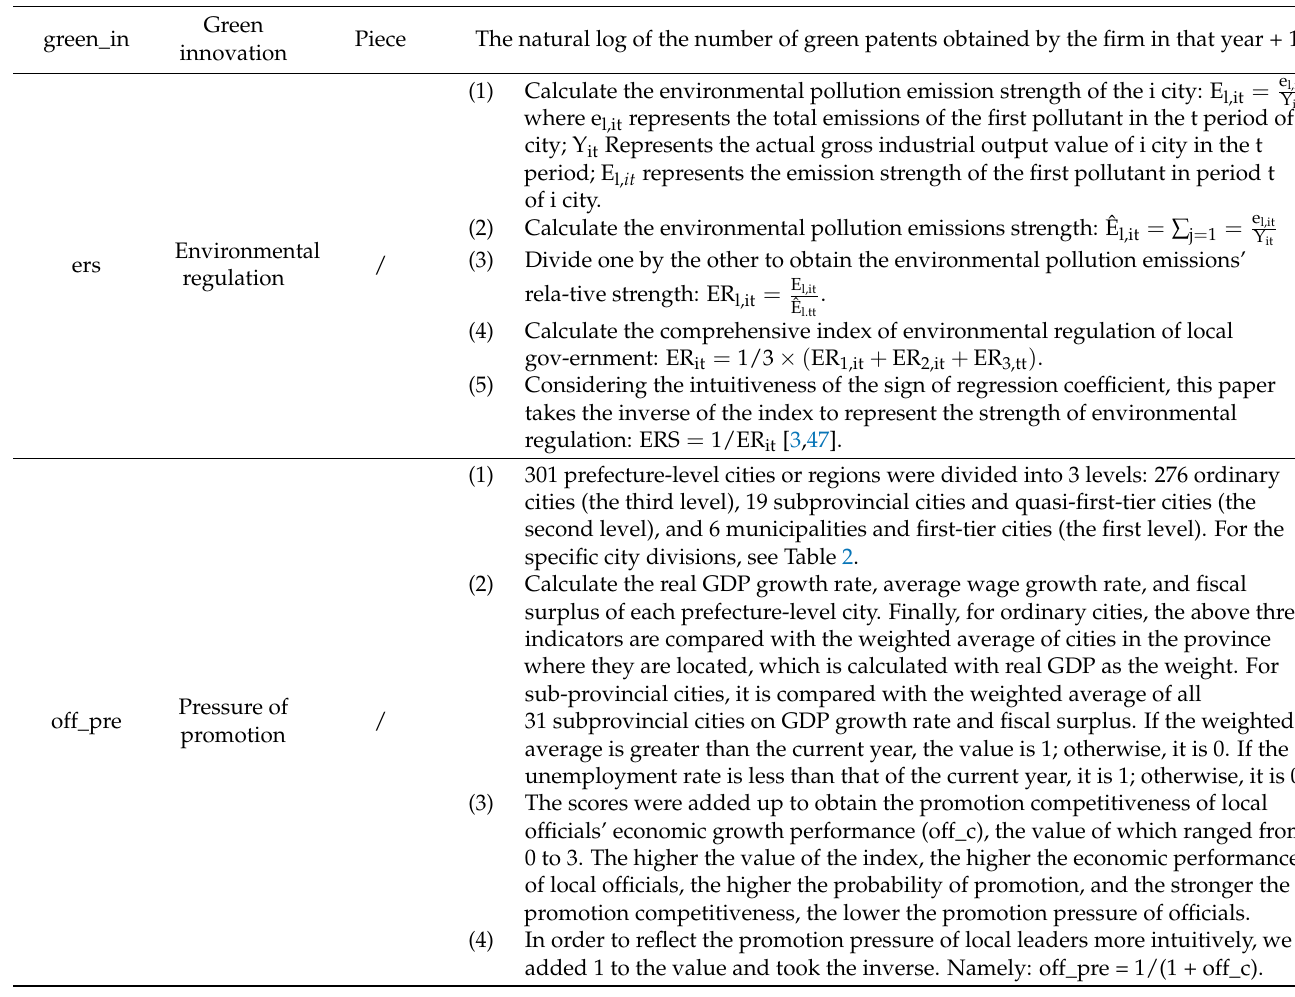
Table 1. Variable definitions.